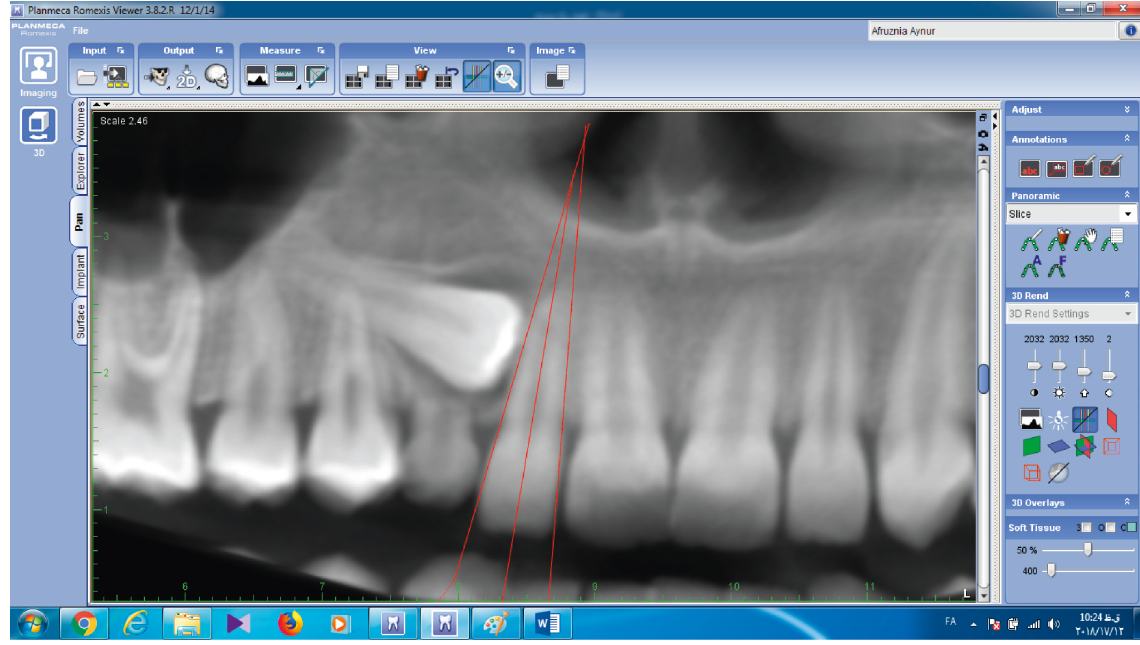
Figure 5: Longitudinal axis and marginal ridges for positioning with the Lindauer